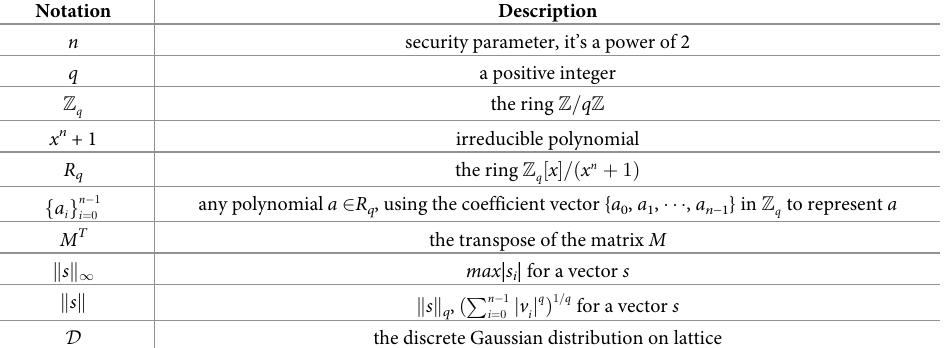
Table 1. Description of